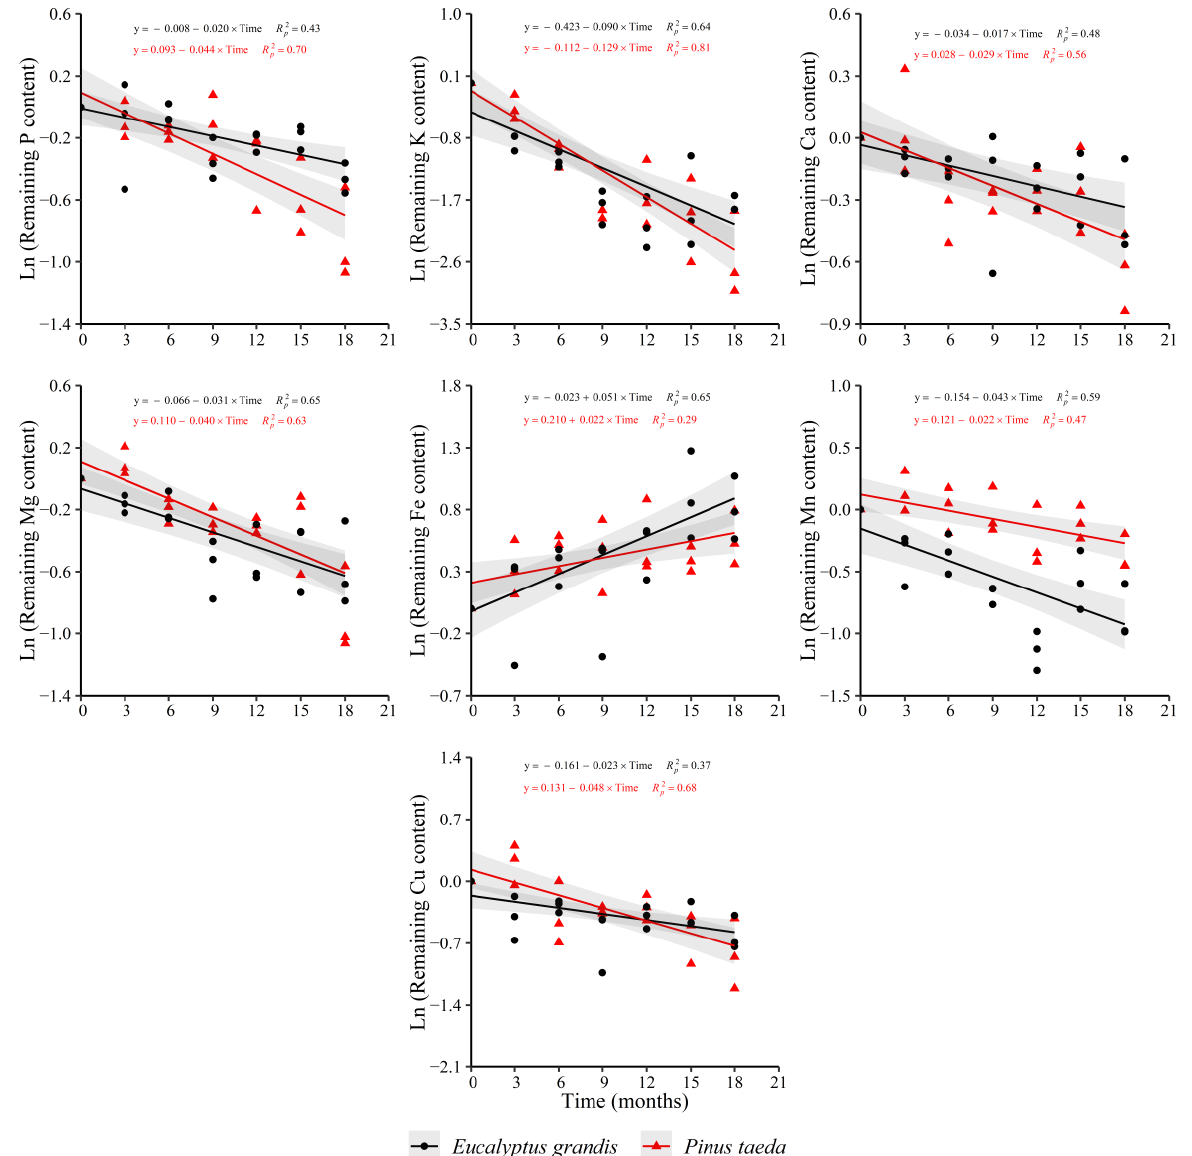
Figure 6. Remaining nutrient content of E. grandis (black symbols) and P. taeda (red symbols) litter for the different sampling moments (C2 layer). The gray bands around the models represent the 95% confidence interval.